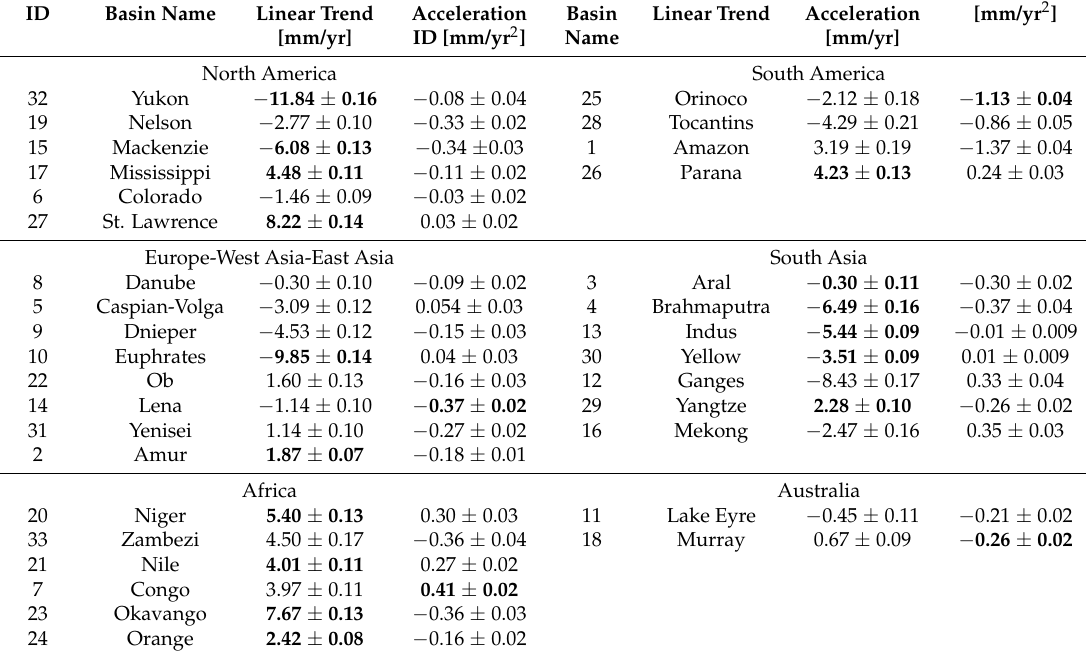
Table 2. The amplitude of linear trend [mm/yr] and acceleration [mm/yr 2 ] fitted to the basin averaged reconstructed global terrestrial water storage change (TWSC) fields within the world’s 33 major river basins covering 2003–2019. Statistically significant trends and accelerations are distinguished by bold text. Note that only the first two digits after the decimal point are